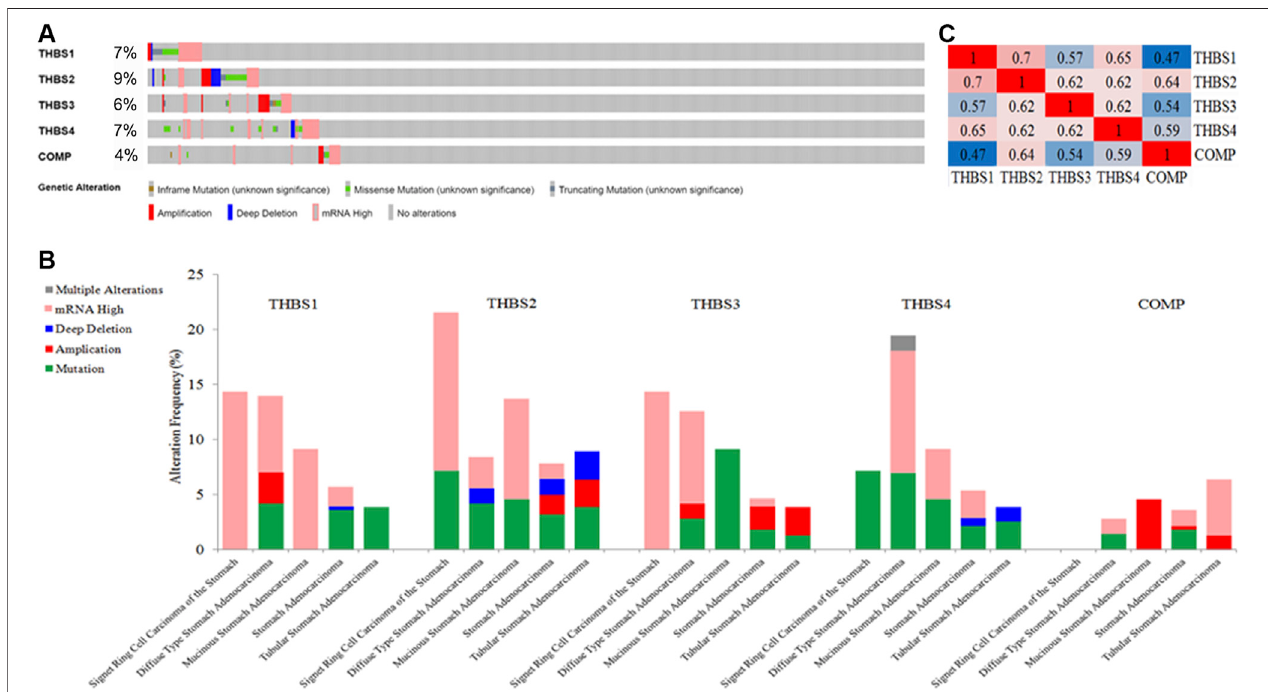
FIGURE6|(A) Oncoprintof THBSs alterationsingastriccancer(GC); (B) cancertypesummaryof THBSs alterationsingastriccancer(GC); (C) mutualcorrelations of THBSs in GC